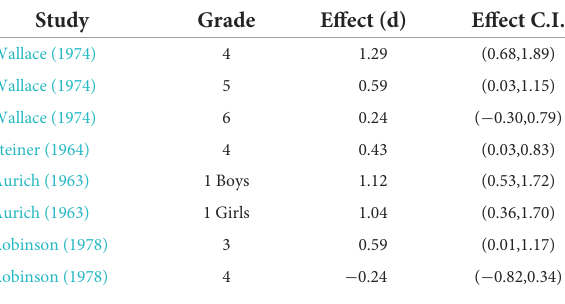
TABLE 2 Pre-post-test effect size (d), Confidence Intervals (C.I.) for the influence of Cui on arithmetic proficiency outcomes.